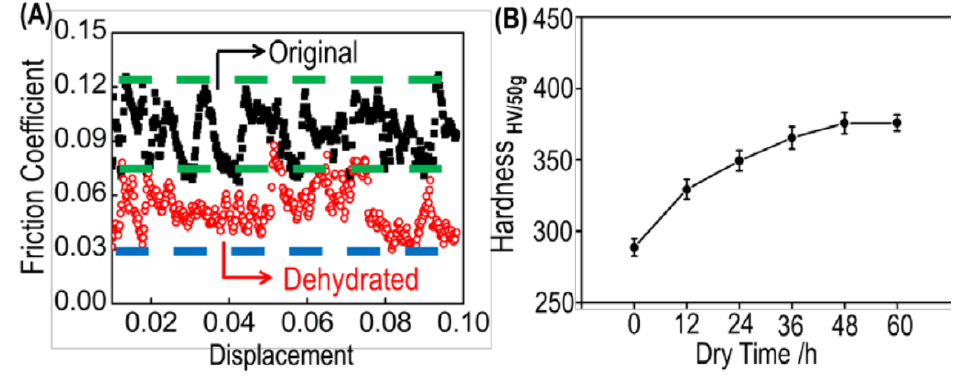
Figure 8. Observations of a) friction coefficient of enamel wet vs dry, and b) Hardness of enamel with dehydration time